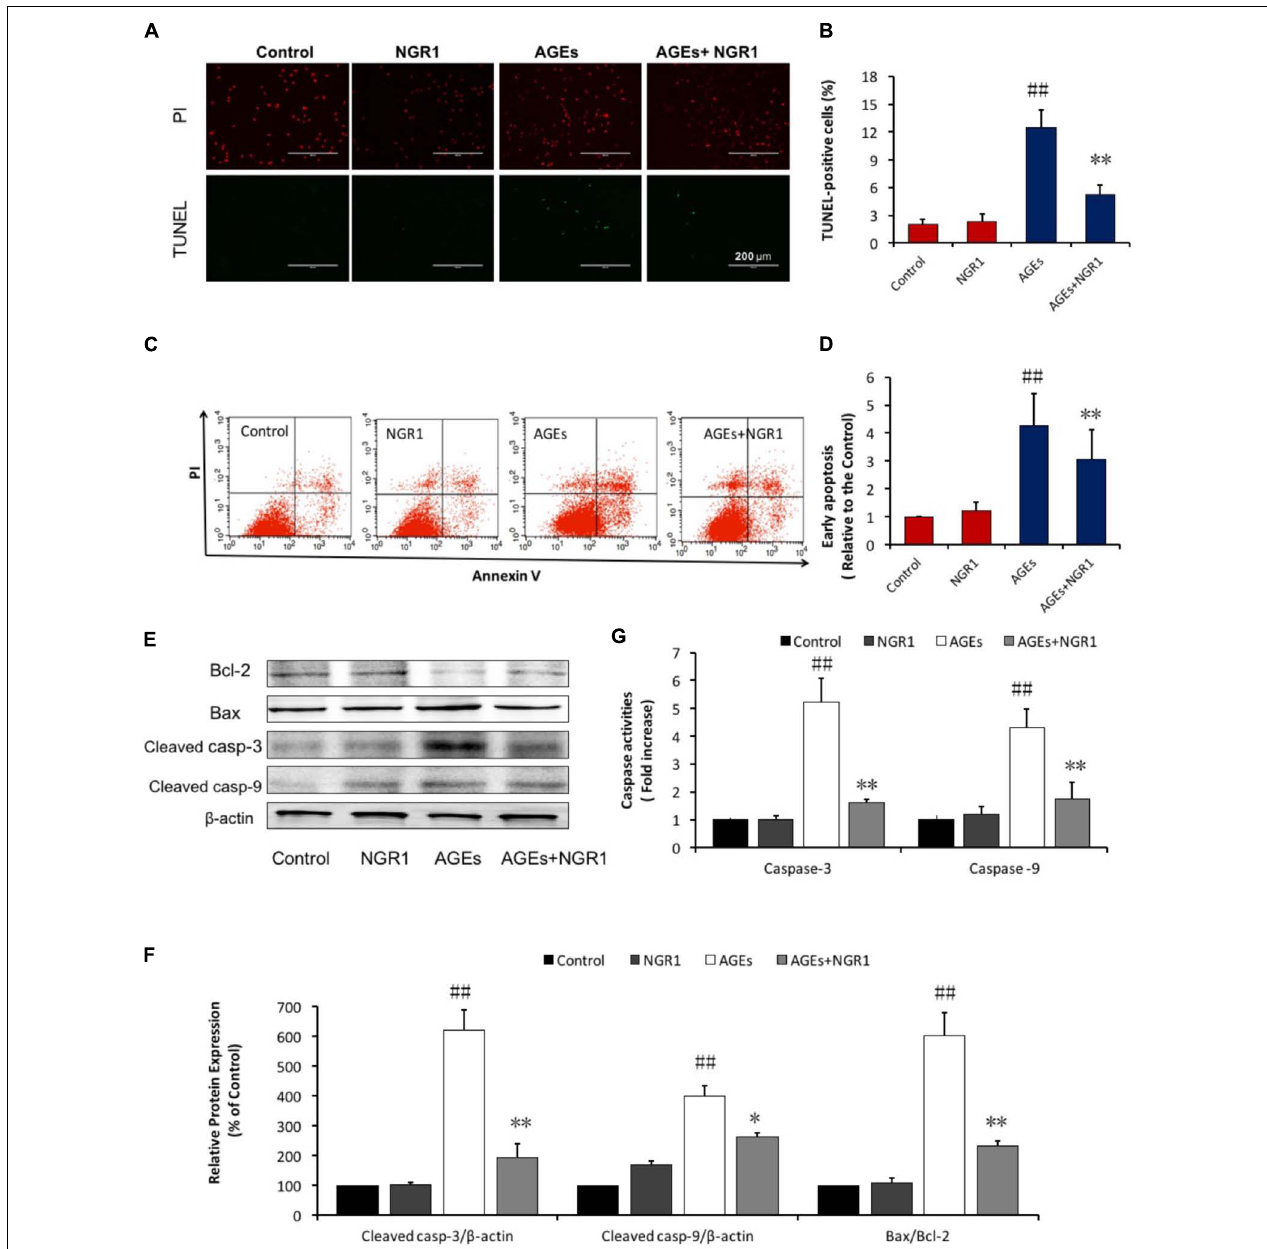
FIGURE 3 | NGR1 attenuates H9c2 cell apoptosis induced by AGEs. (A) Representative images and (B) bar graphs of TUNEL-positive nuclei in green fluorescent color. The bar represents 200 µ m. (C,D) Quantitation of flow cytometry analysis showed that NGR1 inhibited AGEs-induced H9c2 cardiomyocyte apoptosis. (E) The expression of apoptosis-related proteins in H9c2 cells by immunoblotting analysis. (F) The relative expression levels of cleaved caspase-3, cleaved caspase-9, and Bax/Bcl-2 compared to β -actin are expressed in bar graphs. (G) Caspase-3 and caspase-9 activation measured by fluorometric assay. The quantitative data are presented as the mean ± SD of three independent experiments. ## P < 0.01 vs. the Control group; ∗ P < 0.05 or ∗∗ P < 0.01 vs. the AGEs